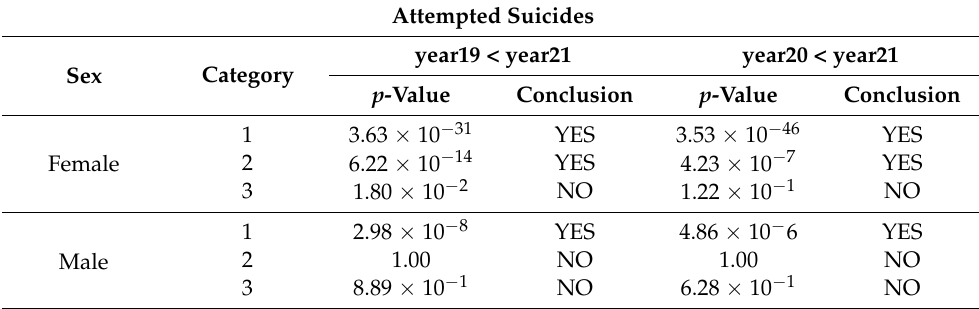
Table 7. Summary of test results for proportions—suicide attempts.